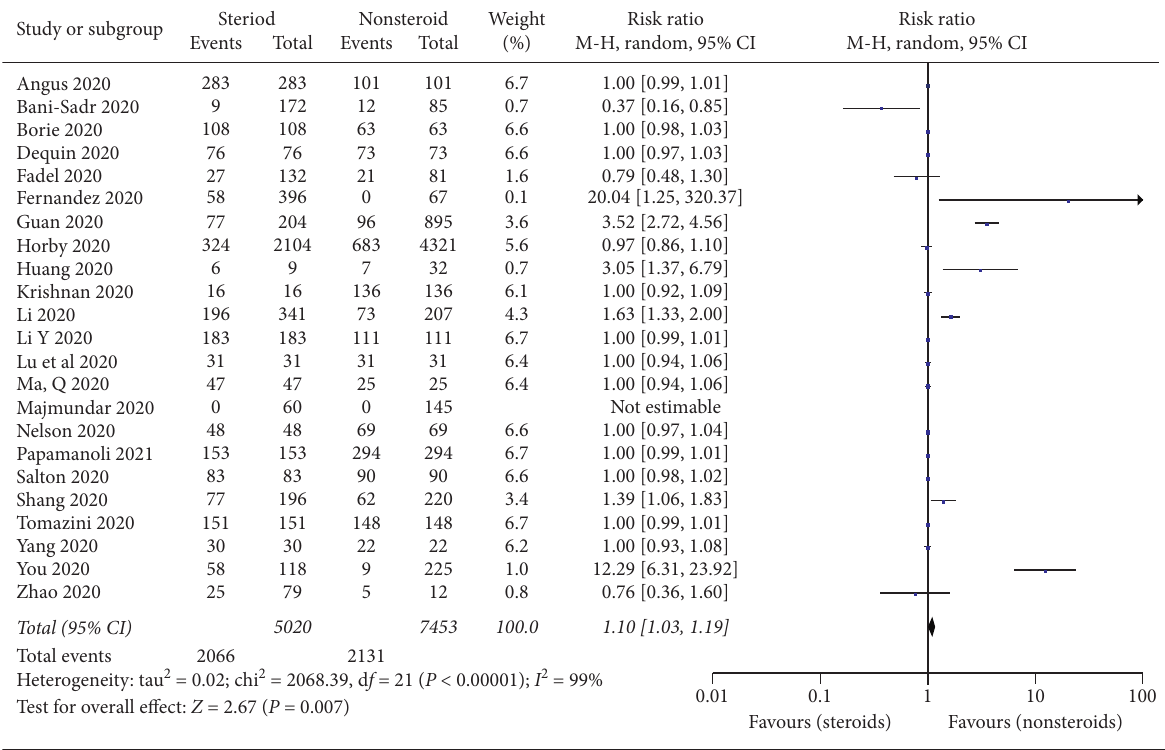
Figure 4: Forest plot for severe events of COVID-19 patients taking steroids versus nonsteroids.